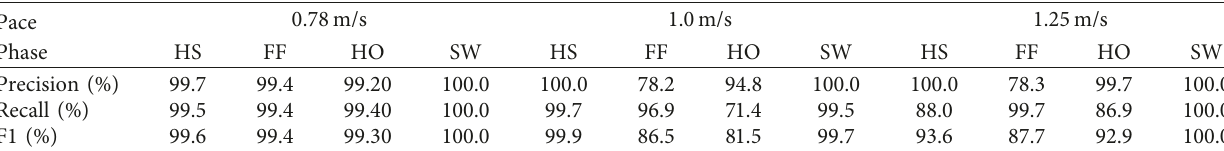
Table 4: Summary of classification performance of AdaBoosting at unsynchronized speed.